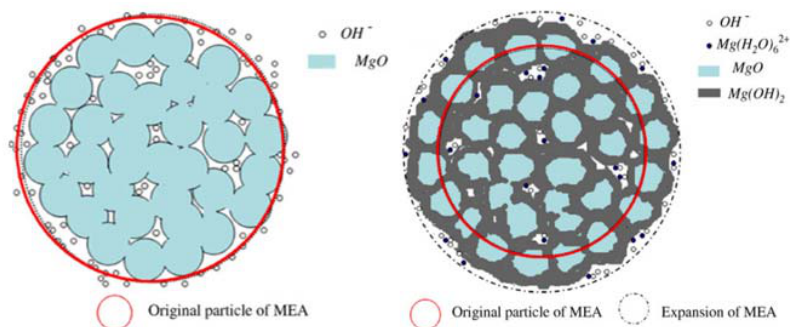
Figure 10. Hydration and expansion model of the MEA with less pores and with low activity in the cement paste Reprinted with permission from Professor Mo Liwu, Copyright 2009 Elsevier Ltd [34].